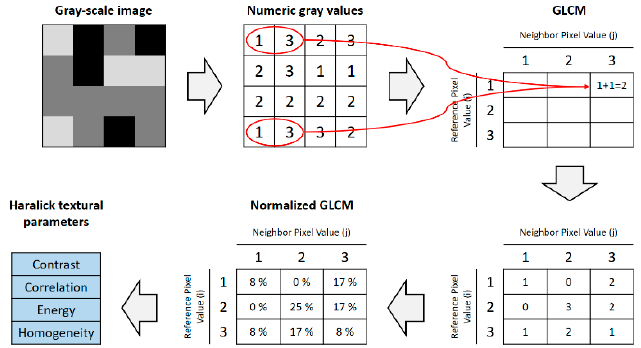
Figure 3. Visualization of calculation of Haralick Parameters: input is a gray-scale image from which the gray level co-occurrence matrix (GLCM) is calculated. Using mathematical matrix operations, di ff erent parameters like contrast, correlation, energy and homogeneity can be calculated from the GLCM. Diagram is modified according to